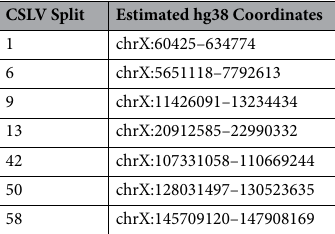
CSLV Split Estimated hg38 Coordinates